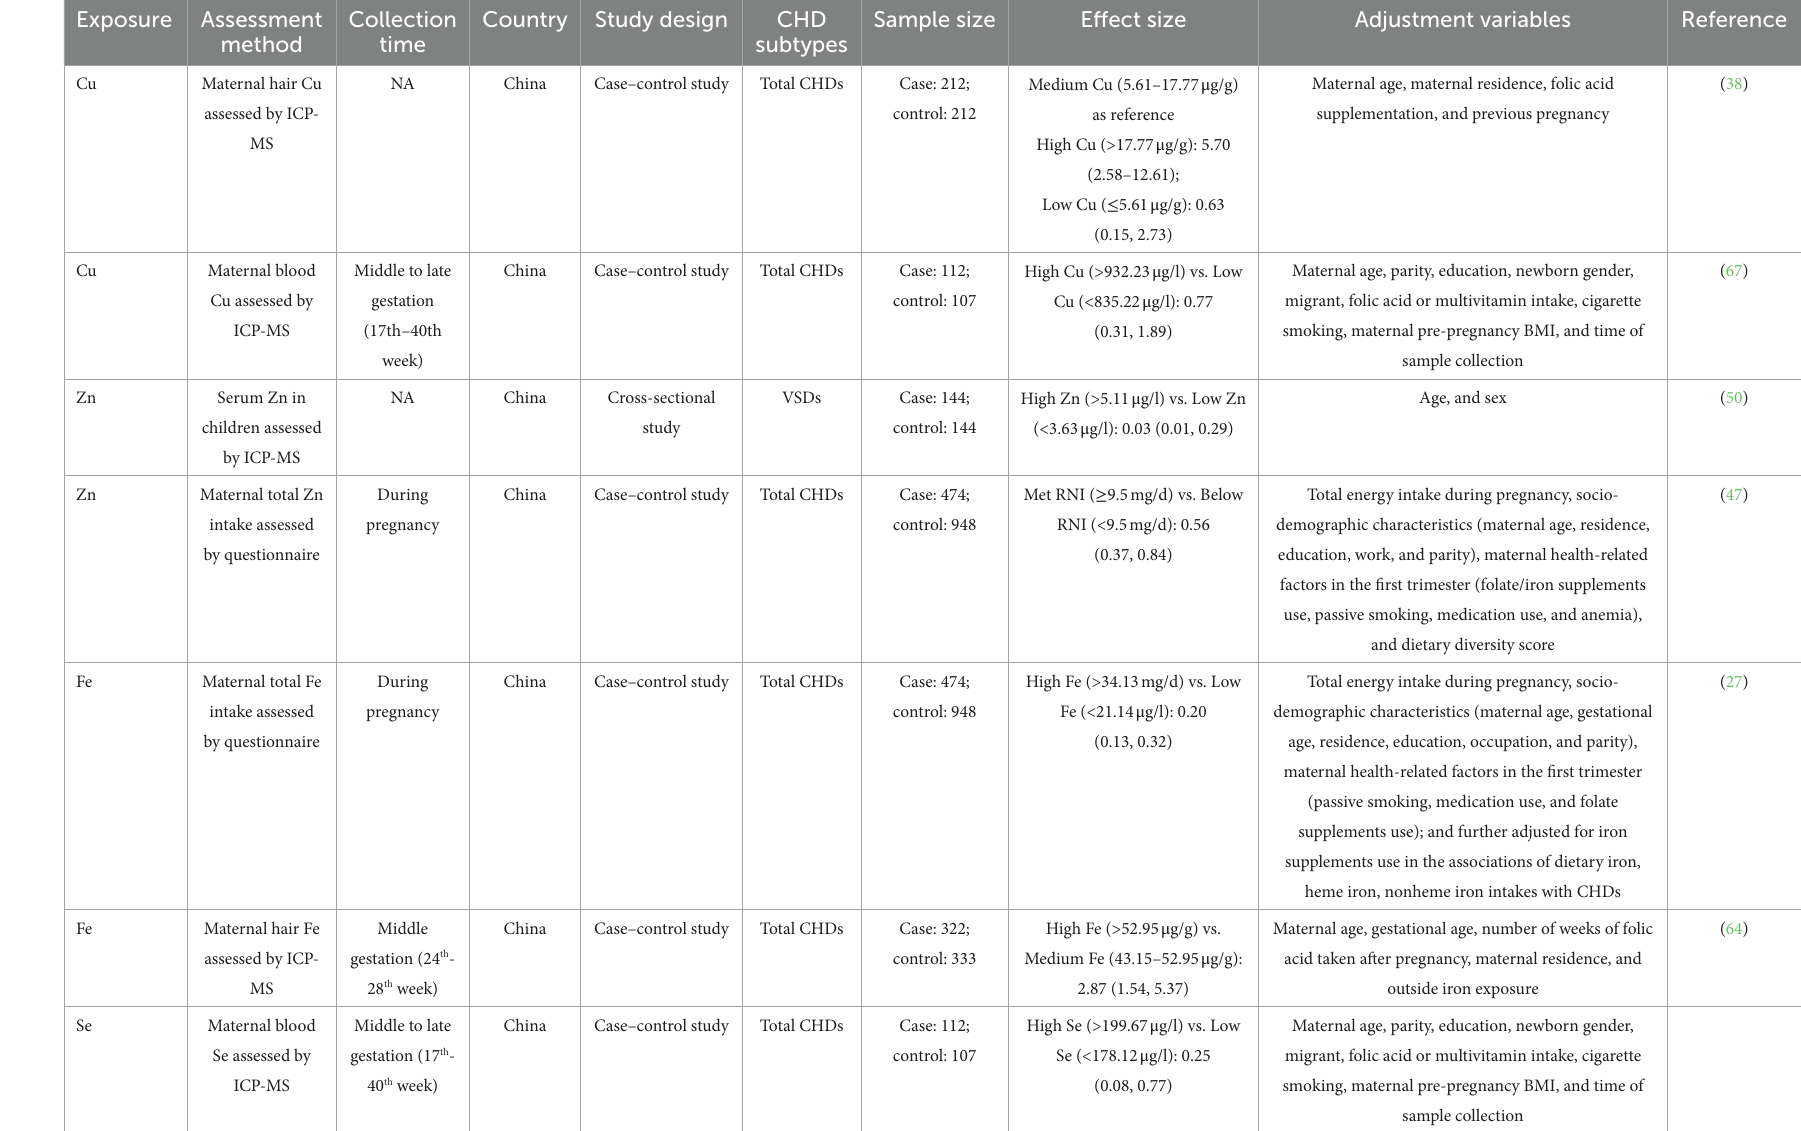
TABLE 1 Summary of epidemiological studies reporting the relationship between essential trace element exposure and